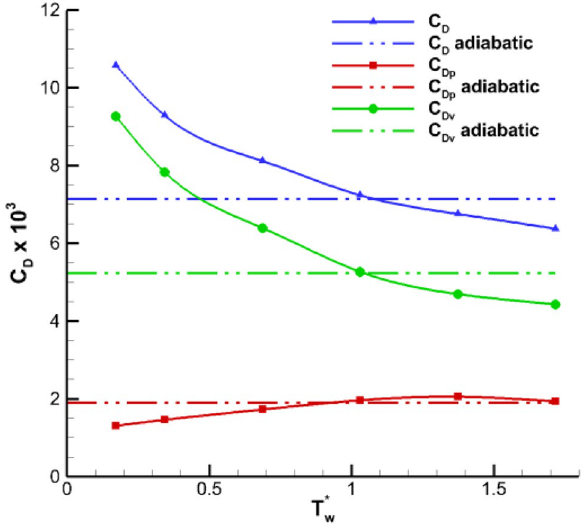
Figure 8. Influence of temperature gradient on model drag coefficients ( M = 0.9, α = 2°).